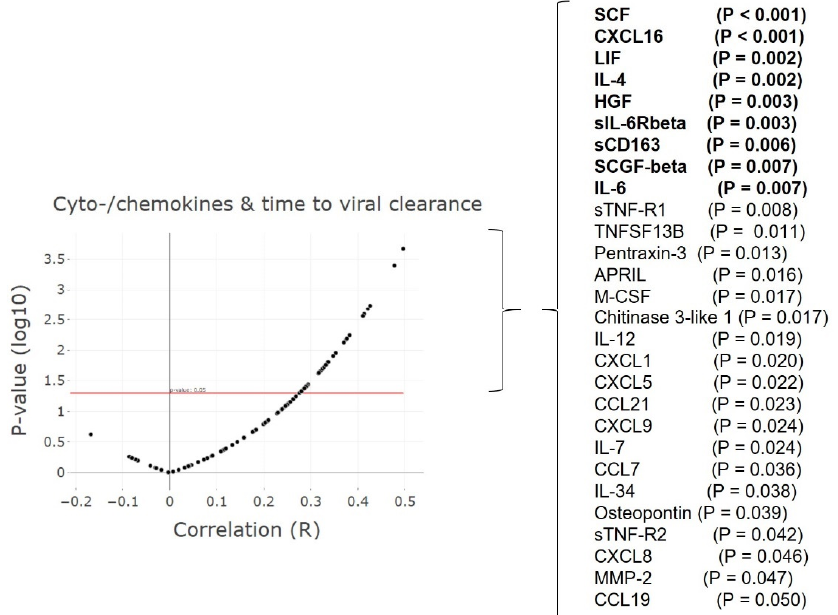
Figure 6. Higher levels of pro-inflammatory cyto/chemokines correspond with delayed viral clearance. Volcano plot: cytokines and chemokines (maximum levels) correlated with the time to viral clearance, a selection based on p -value ≤ 0.05, with R ≥ 0.4 in bold. An overview of all cytokines and chemokines assessed is listed in Supplementary Table S2. n = 51 patients, 321 samples. Spearman’s rank correlation (rho).